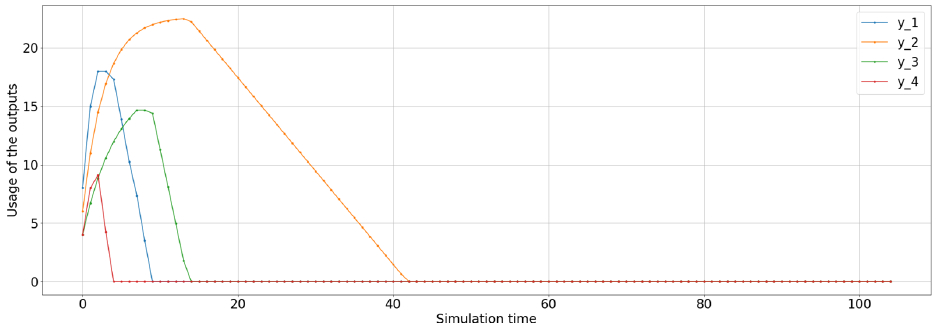
Figure 10. Objective function cost of the centralised MPC. Under this optimal solution, provided by the proposed centralised MPC, the evaluation of the objective cost function is expected to decrease as quickly as possible (concretely, Figure 10 shows that the cost reaches 0 at simulation step 42). While doing so, Figure 8 shows that the constraint related to the flexibility mechanism is always fulfilled (concretely, the sum of the inputs is always below the maximum value 4). These trade-off results in the optimal sequential evolution of the outputs shown in Figure 9. For benchmarking such an optimal solution, Figures 11–13 summarise the result of the non-optimal decentralised MPC. Specifically, Figure 11 shows the solution for the u- variables (inputs of the nodes), Figure 12 shows the results for the y-variables (outputs of the nodes), and Figure 13 shows the evolution of the sum of the local objective function costs under the decentralised MPC simulation in comparison with the aggregated objective function cost under the centralised MPC. Figure 11. Solution for u-variables of the decentralised MPC.